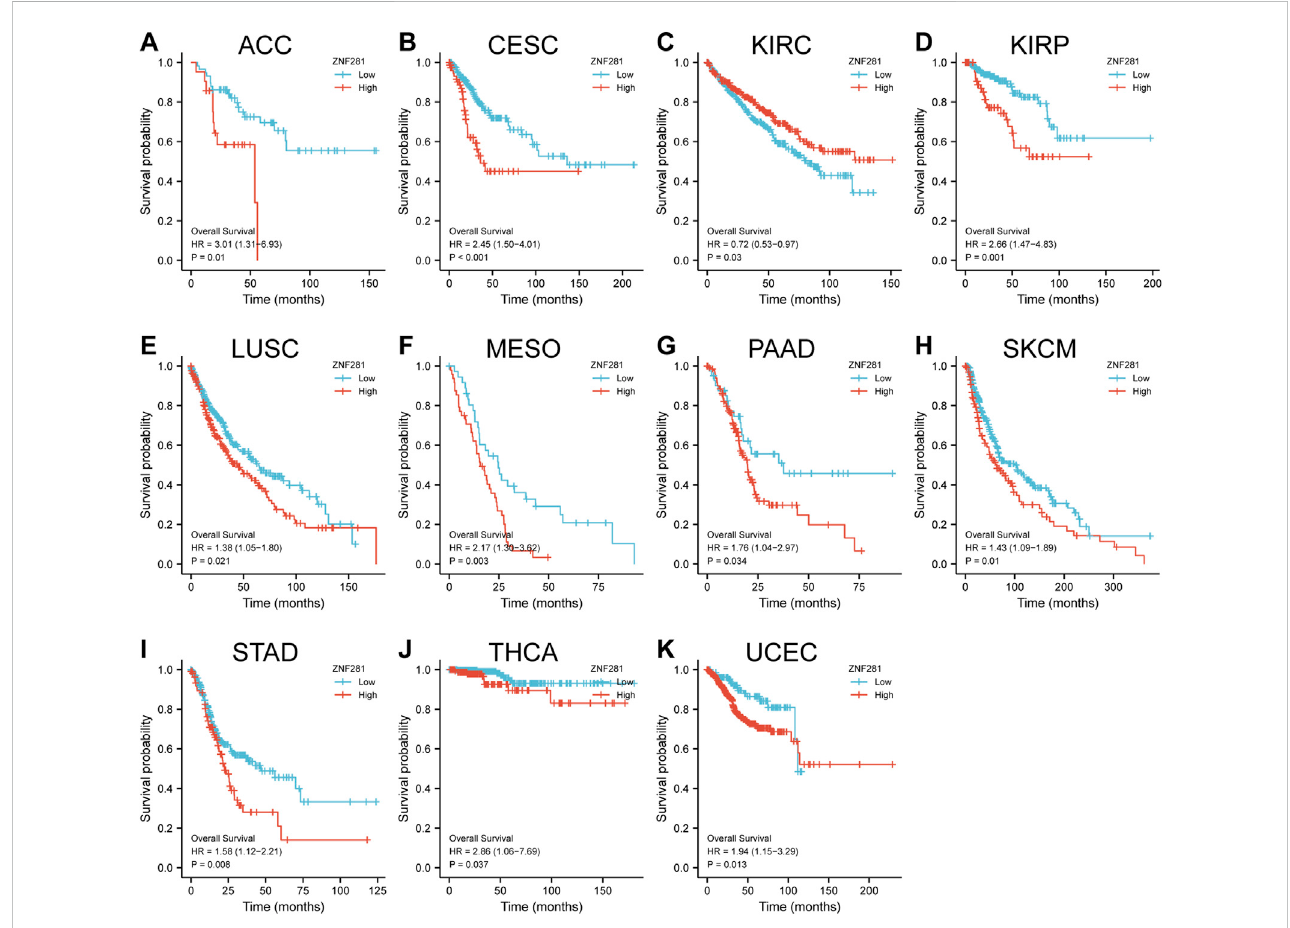
FIGURE 3 Correlations between the ZNF281 expression and prognosis (OS) of patients in different cancers. (A) ACC, (B) CESC, (C) KIRC, (D) KIRP, (E) LUSC, (F) MESO, (G) PAAD, (H) SKCM, (I) STAD, (J) THCA, and (K) UCEC.